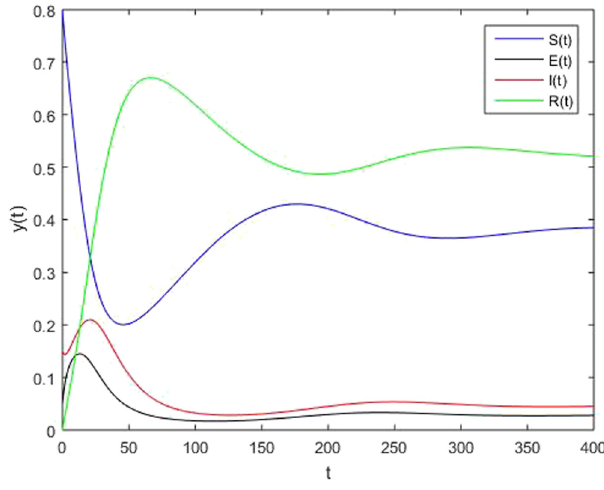
Figure 4: A solution to the SEIR model with fractional order α = 0.98.